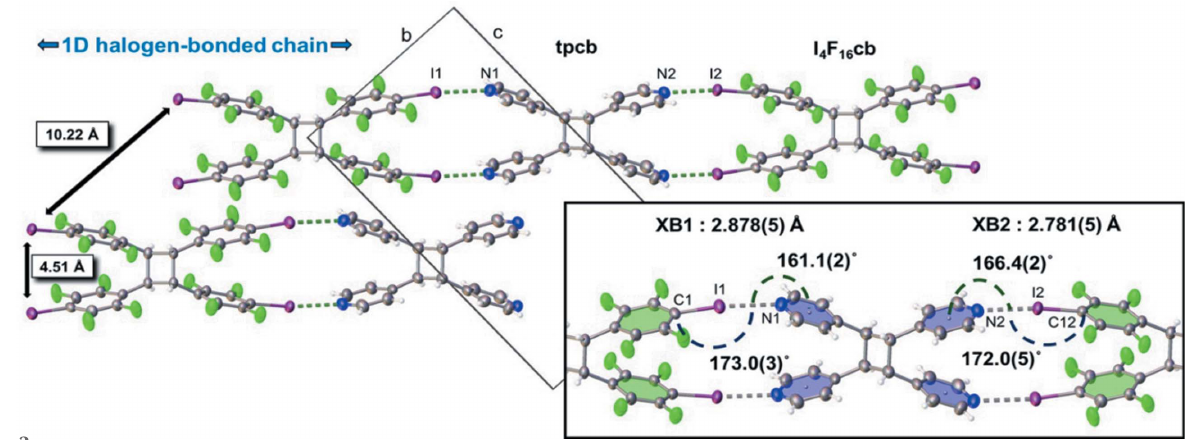
Figure 3 X-ray structure of (I 4 F 16 cb) (cid:2) (tpcb) showing cyclobutane formation (inset: halogen-bonding